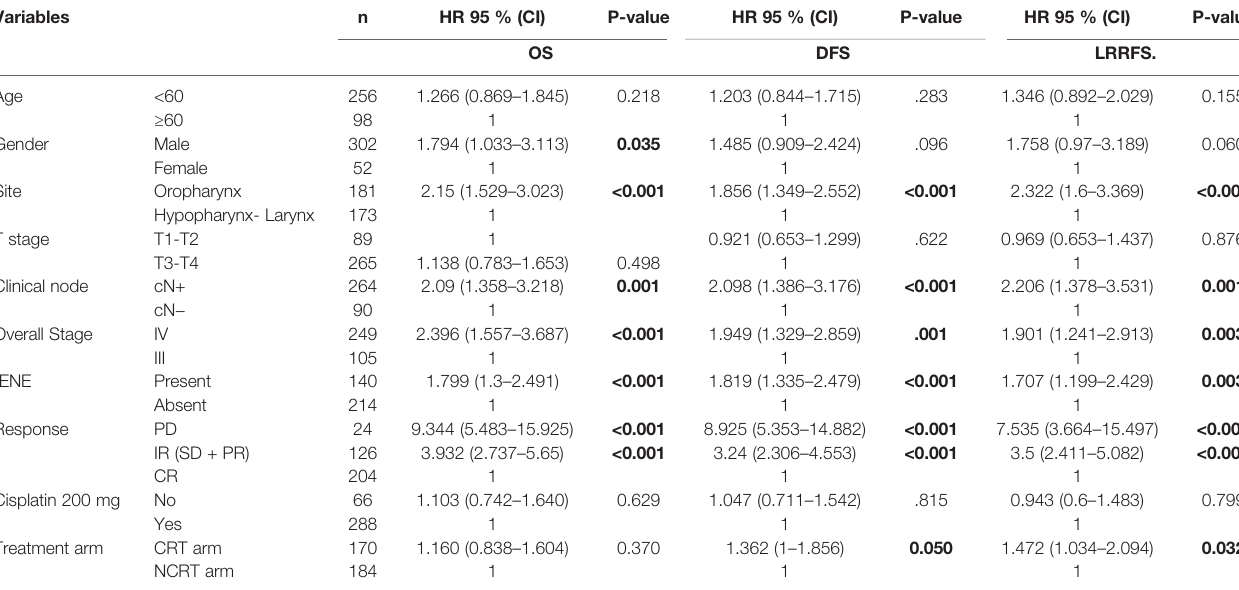
TABLE 3 | Univariate analysis for OS, DFS and LRRFS.